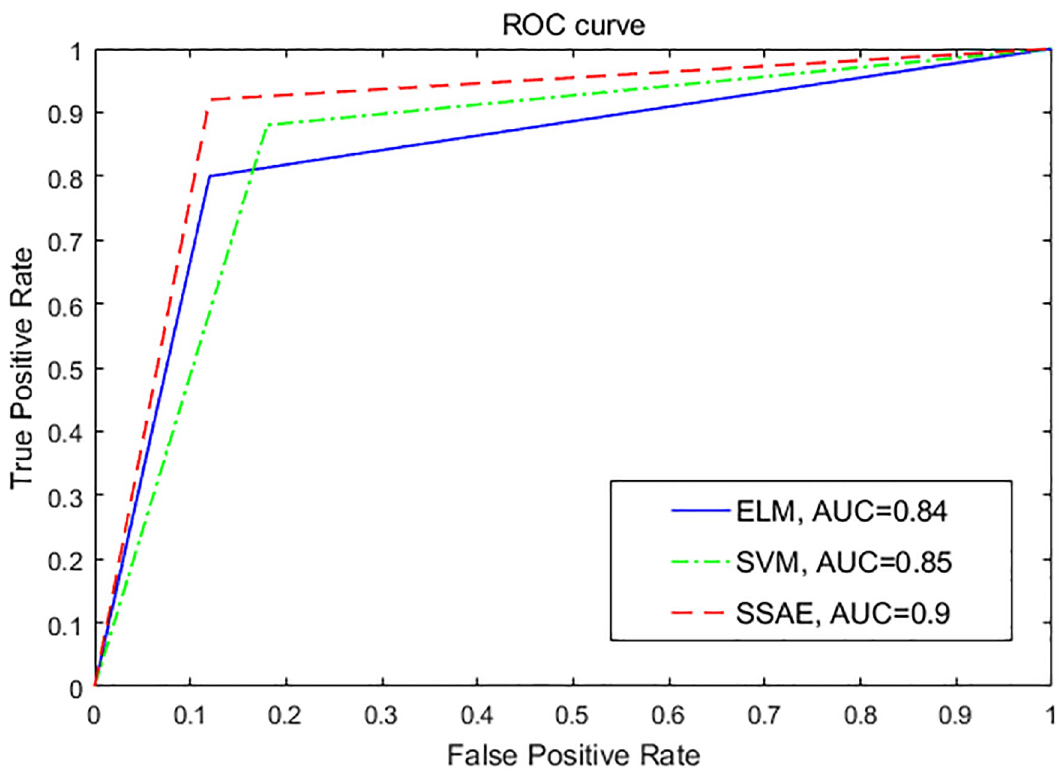
Fig 10. The ROC curve for the three